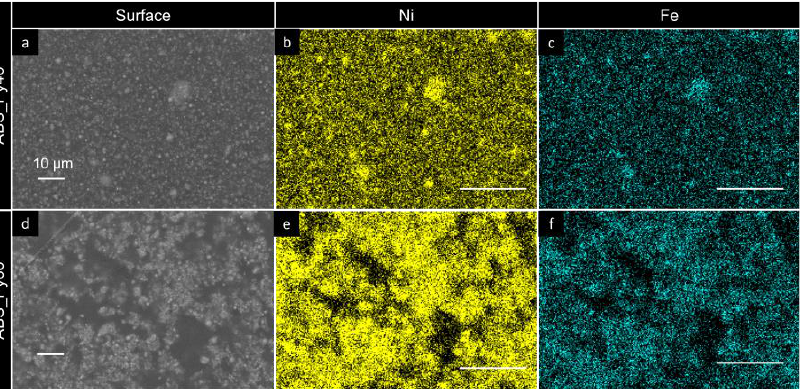
Figure 4. Energy-dispersive X-ray spectroscopy (EDX) images at magnifications of 2500x of the sur- face of the composites containing 40 wt% permalloy ( top row ) and 60 wt% permalloy ( bottom row ). The scale bars in the images represent 10 µm. ( a ) and ( d ) Surface image. ( b ) and ( e ) EDX maps of the Ni atoms distributions. ( c ) and ( f ) EDX maps of the Fe atoms distributions.